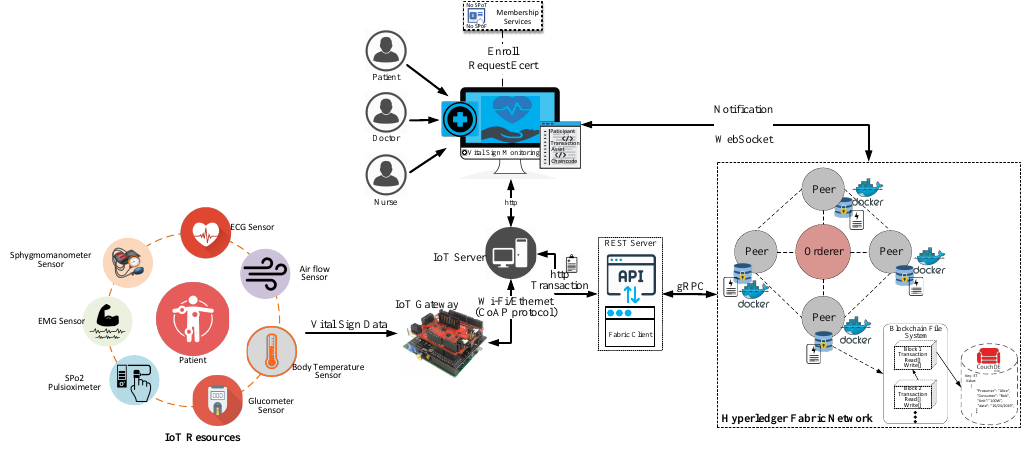
Figure 6. Healthcare IoT blockchain platform implementation and use case deployment for secure monitoring of vital